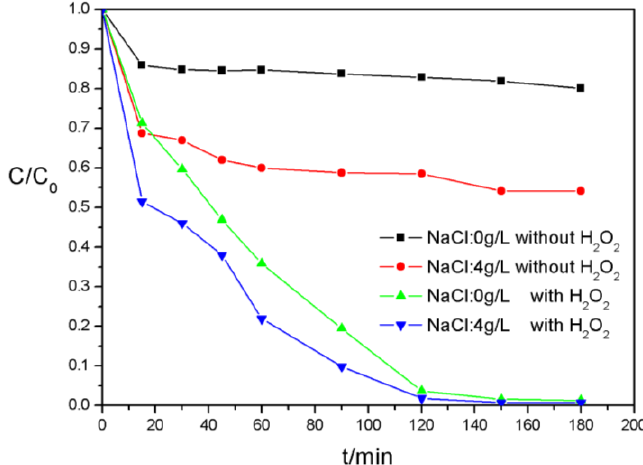
Figure 11. Effect of salinity on catalytic oxidation of AO7 [ C (AO7) = 5 × 10 −5 mol/L, C (H O ) = 4.85 × 10 −2 mol/L, C (CoTCPcNa-AN-CNFs) = 0.667 g/L, 25 2 2